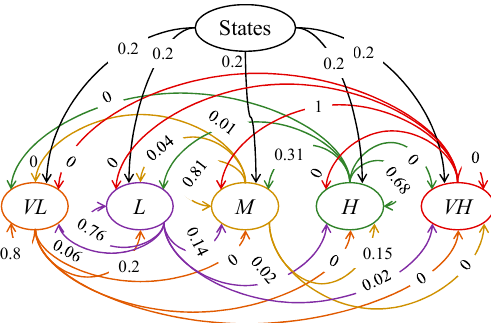
Figure 5. Outlining phenomenon twin construction of surface roughness using the Markov chain- based modeling approach [17]. Figure 6. Outcome of Markov chain-based MC.